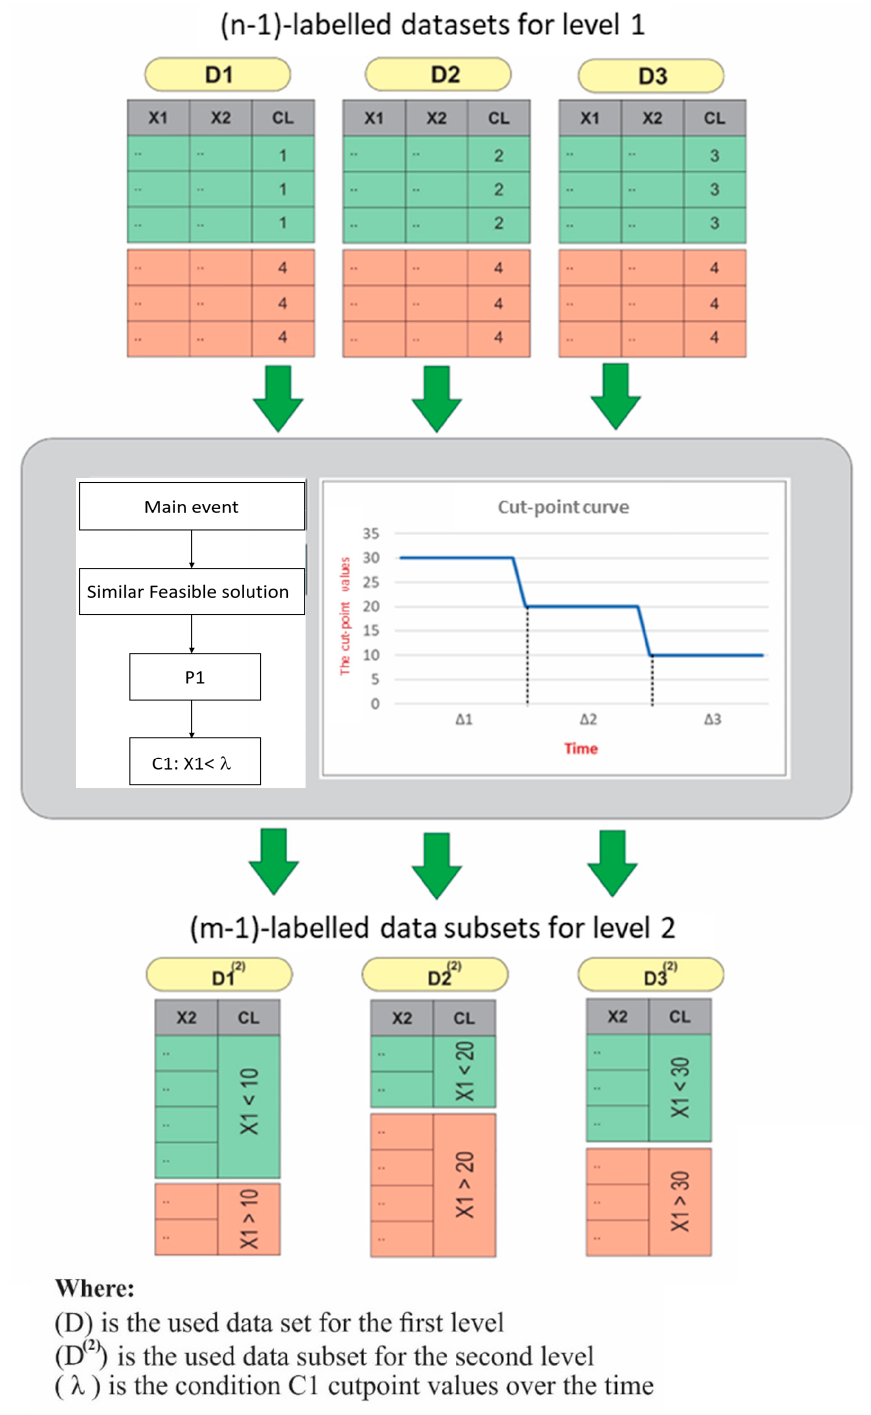
Figure 6. Generating new labelled data subsets in the ITCA